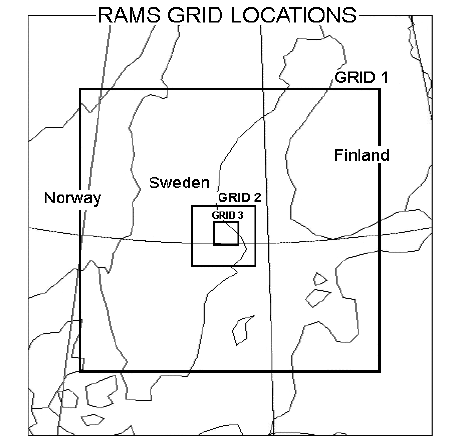
Figure 2. The model domain with its three different nested